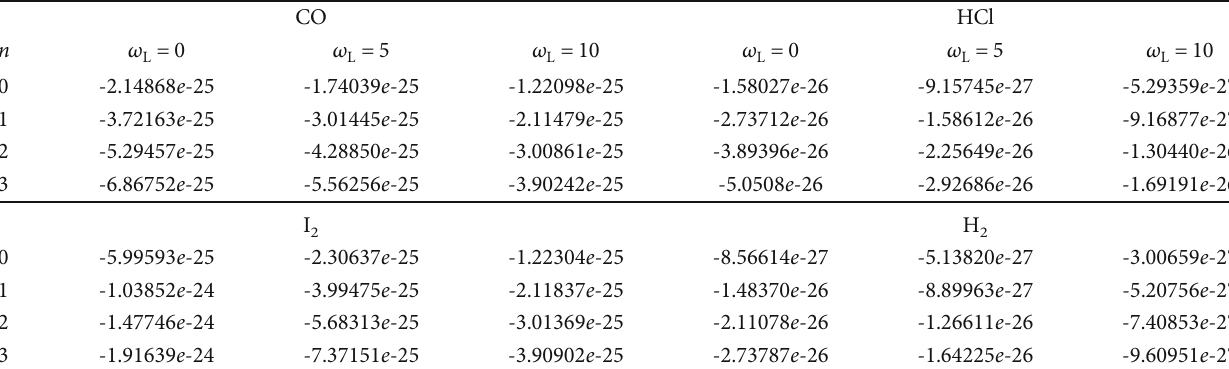
, and H molecules bounded by the isotropic oscillator plus inverse quadratic potential for 2 2 with g = m = 1 L